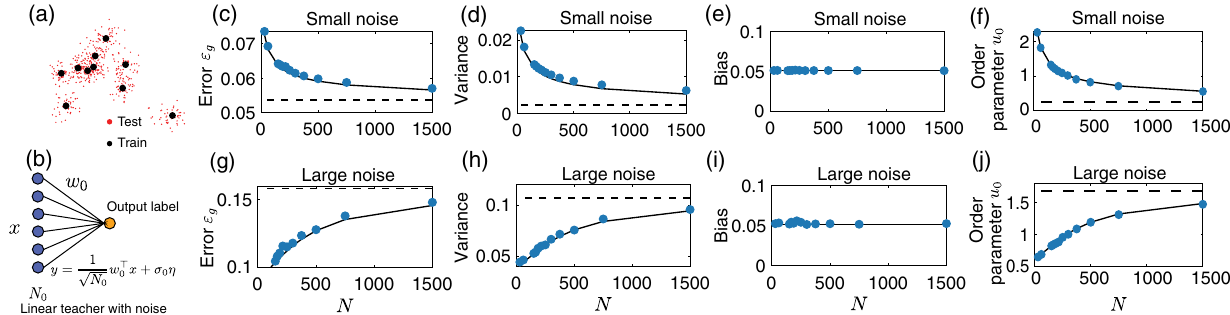
FIG. 3. Dependence of network behavior on hidden-layer width N . (a) Schematics of inputs in the template model: N 0 -dimensional vectors clustered around P templates (shown as black dots), which are used as training vectors. The testing data (shown as red dots) are sampled from the P clusters by adding Gaussian noise to the templates (see Appendix E). (b) Target labels are outputs of a single-layer linear teacher network with weight vector w 0 and additive output noise. (c) – (j) Behavior of a linear network with a single hidden layer ( L ¼ 1 ) vs hidden-layer size (width) N : generalization error (c,g), variance (d,h), and bias (e,i) of the predictor averaged over the test data, and normalized by the amplitude of the labels, and the order parameter u 0 (f,j). We performed the same averaging and normalization for all the following results. Black solid lines: theory. Blue dots: simulation. Black dashed lines: GP limit ( N ¼ ∞ ). Top row: parameter regime with small noise where the generalization error increases with α (i.e., decreases with N ). Bottom row: parameter regime with large noise where the generalization error decreases with α (i.e., increases with N ). (See detailed parameters for the simulation in Appendix